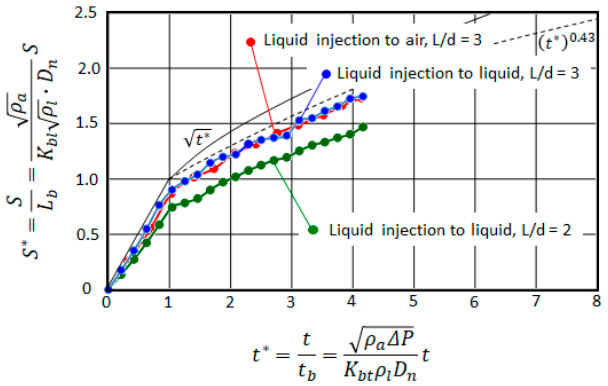
Figure 24. Penetration similarity between fuel-into-air and fuel-into-water injections. Upper time-